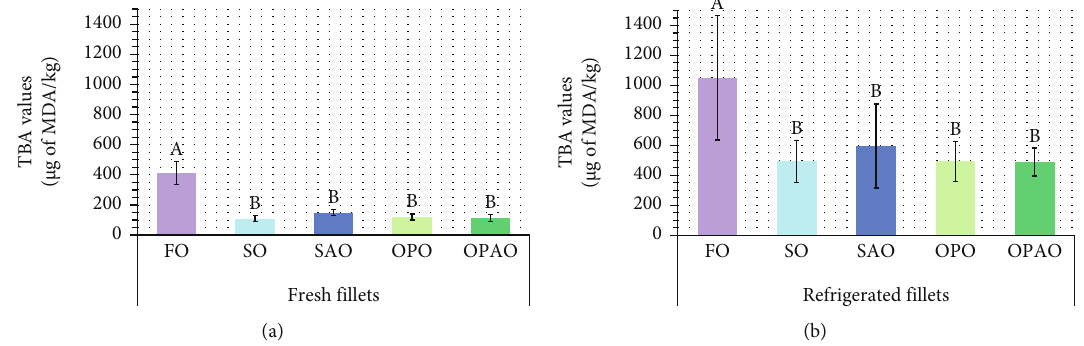
Figure 3: Secondary oxidation: TBA values of fresh fi llets (a) and refrigerated fi llets (b) coming from the di ff erent dietary treatments. The results were represented as mean ± standard deviation ( n = 5 ) of TBA values ( μ g of MDA/kg). The di ff erences between dietary treatments found in fresh or refrigerated fi llets with Sche ff é ’ s post hoc test ( n = 25 ) were noted as A > B. Abbreviations: For diet abbreviations (FO, SO, SAO, OPO, and OPAO), see Table 2; MDA: